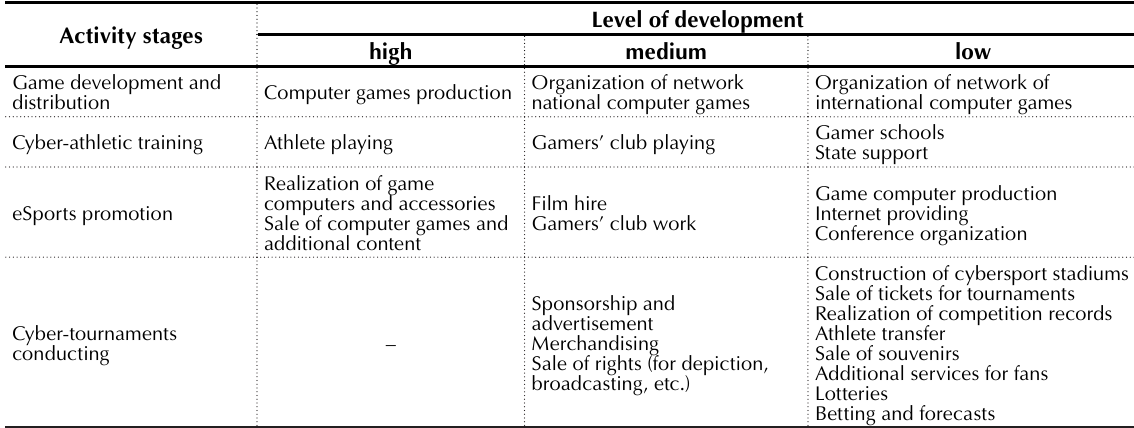
Table 5. Estimation of the development level of commercial activities in eSports in Ukraine according to their